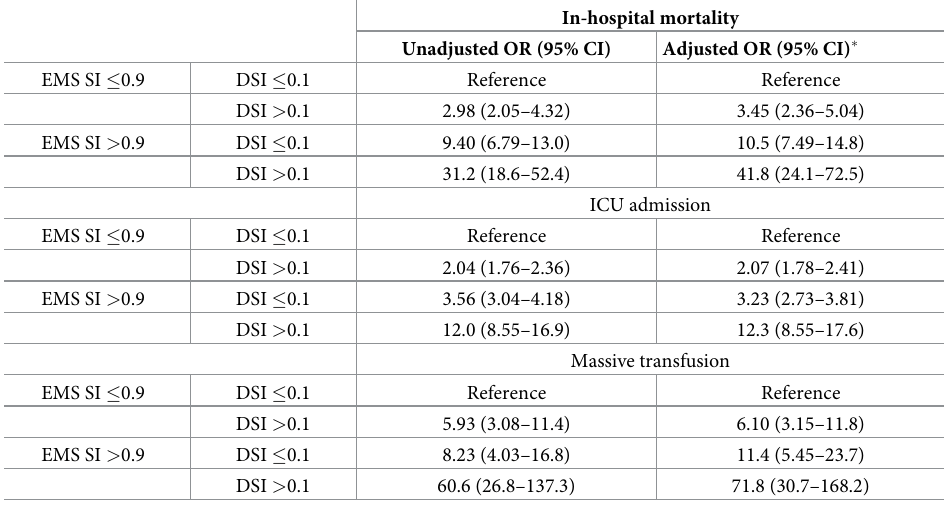
Table 5. Association between exposure groups and outcomes according to prehospital shock index in multivariate logistic